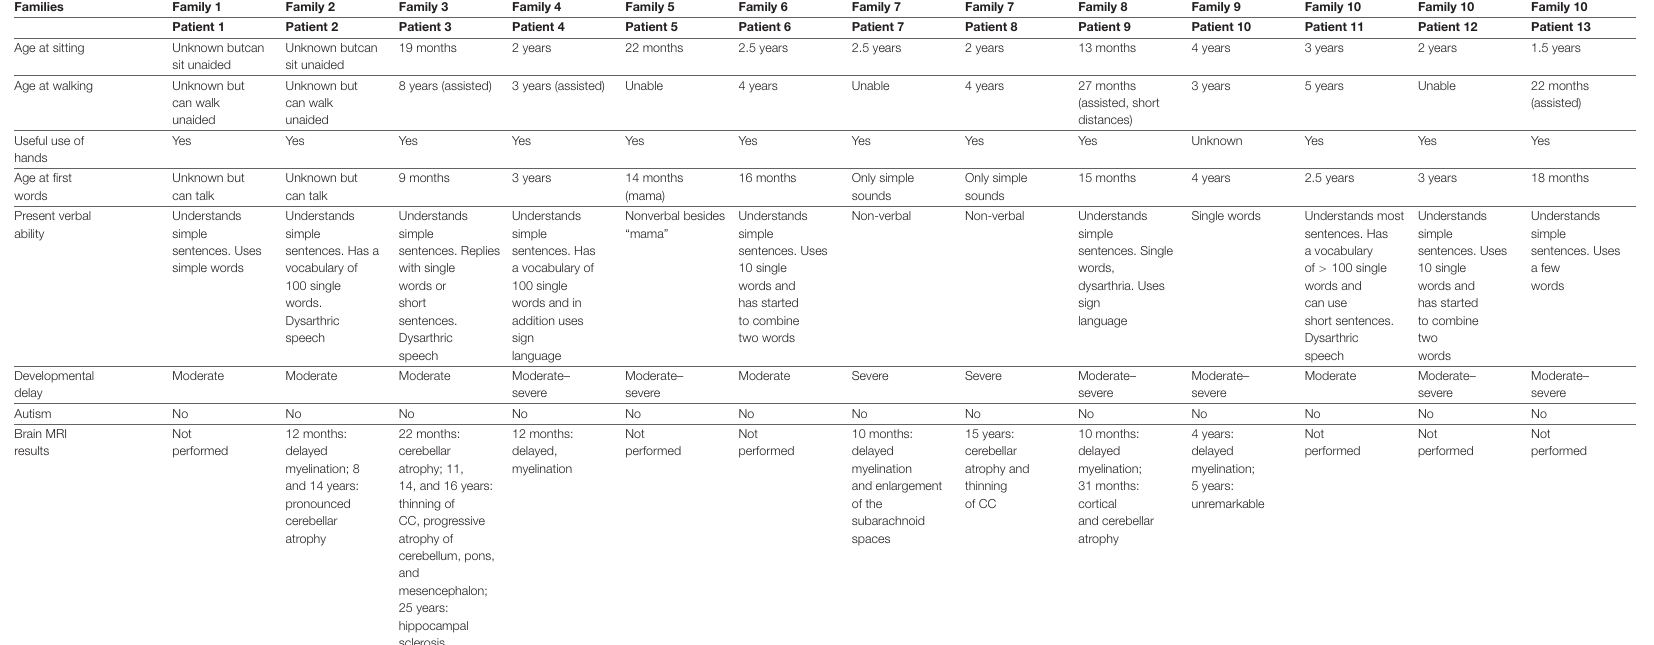
*Overall antiepileptic drug response (very good = seizure-free; partially good = partially seizure-free on treatment; and poor = intractable seizures despite